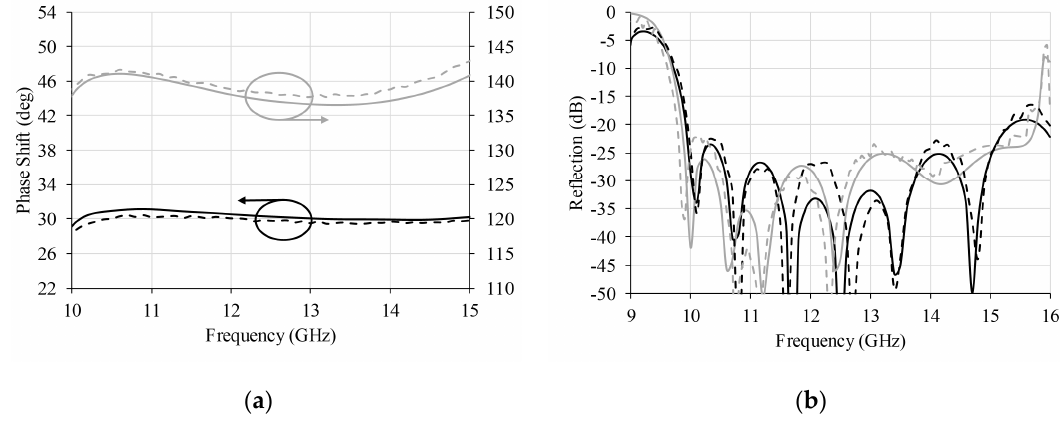
Figure 7. Comparison between simulated (solid lines) and measured results (dashed lines) for the designed 30°-DPS (black lines) and 140°-DPS (grey lines): ( a ) phase difference and ( b ) reflection.